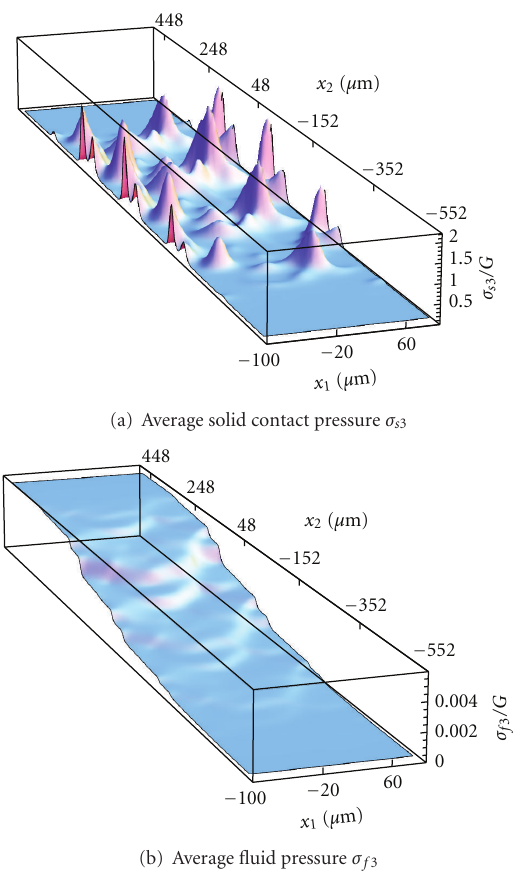
Figure 5: Average fluid and solid contact pressure for the static linear elastic